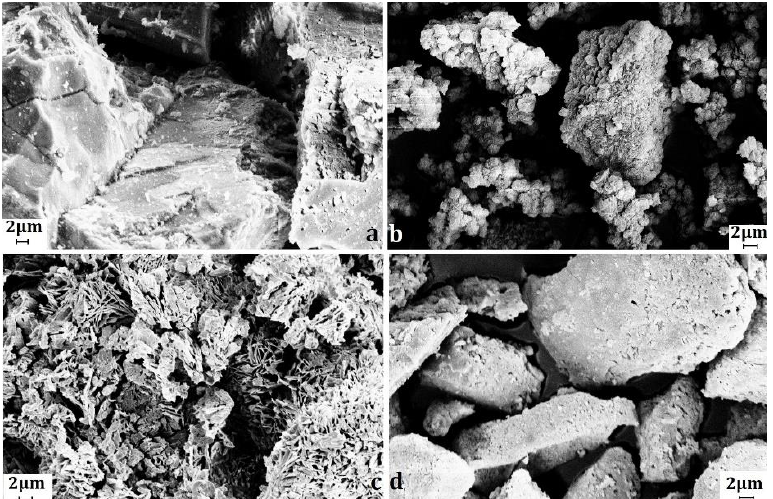
Figure 11. Particle morphology of the concentrate ( a ), concentrate mixture with ammonium sulfate at a ratio 1:7 ( b ), clinker after roasting at 400 °C ( c ), and leach residue ( d ).